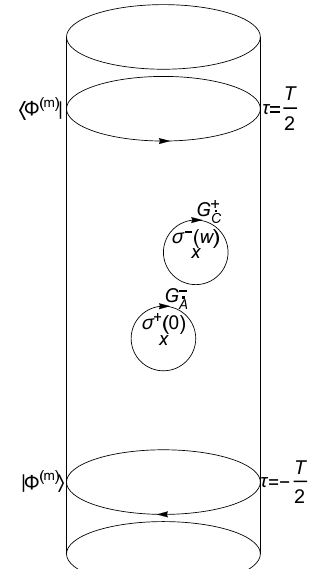
Figure 4 . The cylinder with the locations of the initial state j (cid:8) ( m ) i at (cid:28) = (cid:0) T h (cid:8) ( m ) j at (cid:28) = T